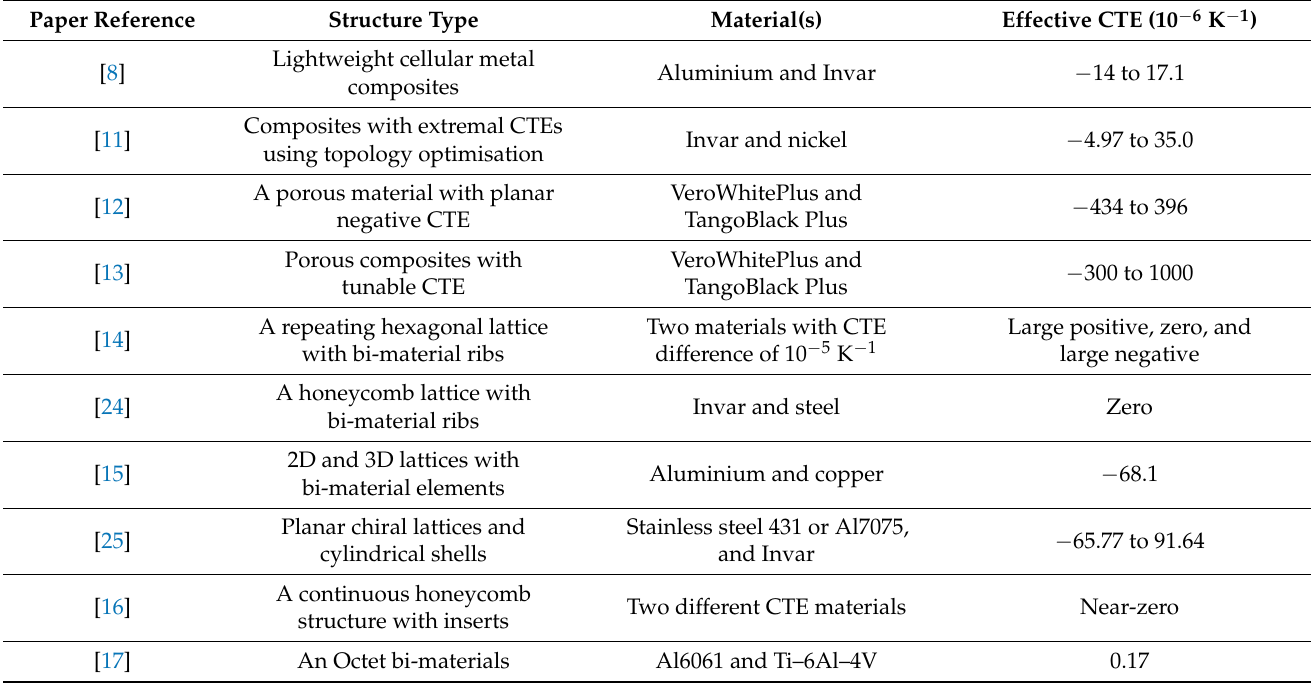
Table 1. Summary of current tailored thermal expansion lattice